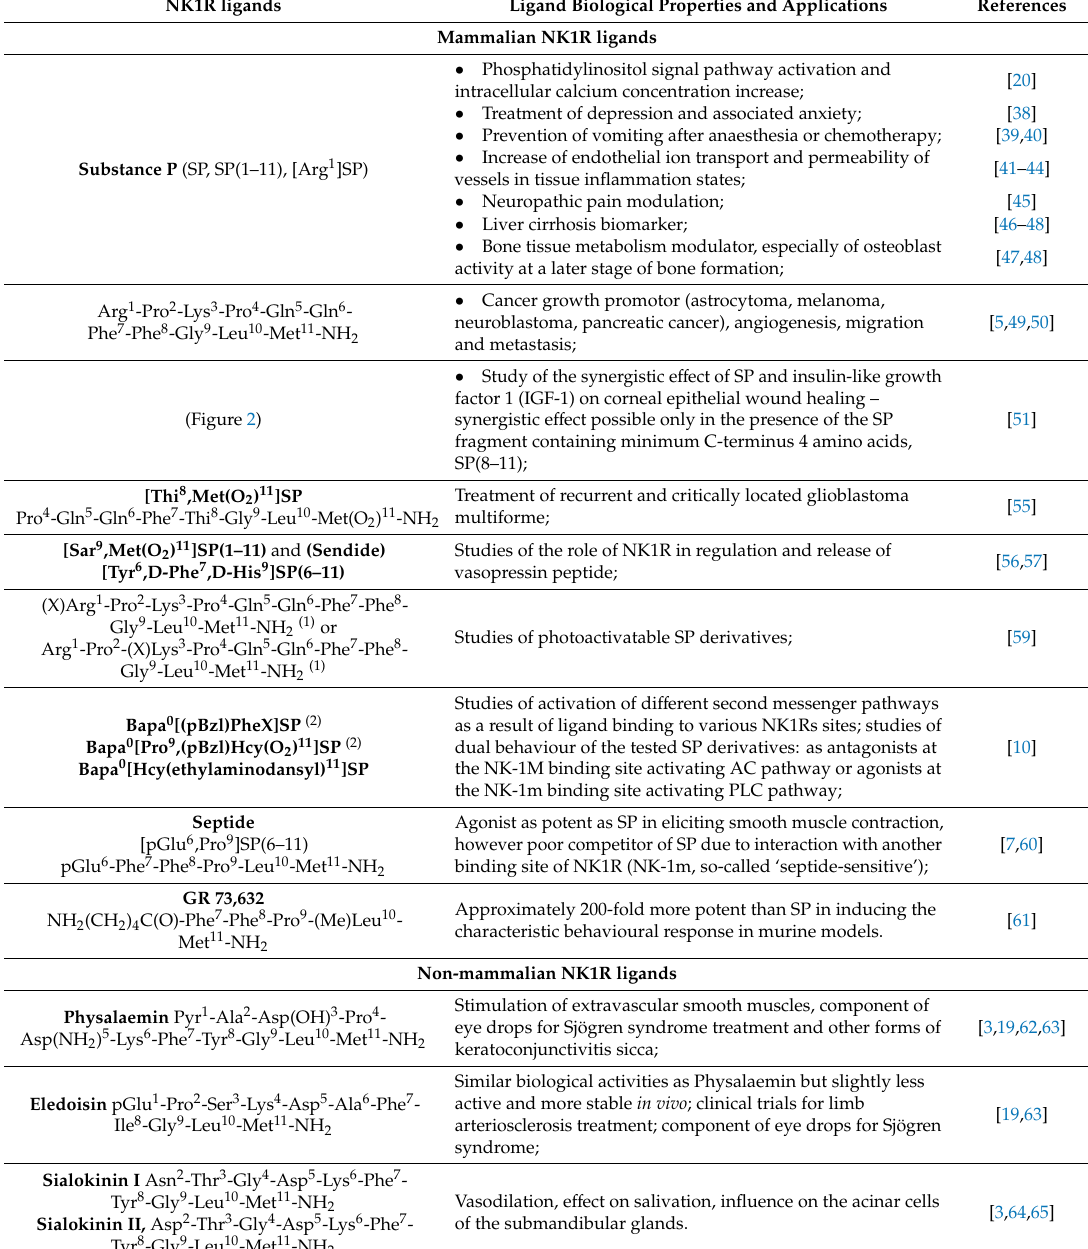
Table 1. Substance P, its analogues and derivatives: biological activity and potential application in classical medicine.